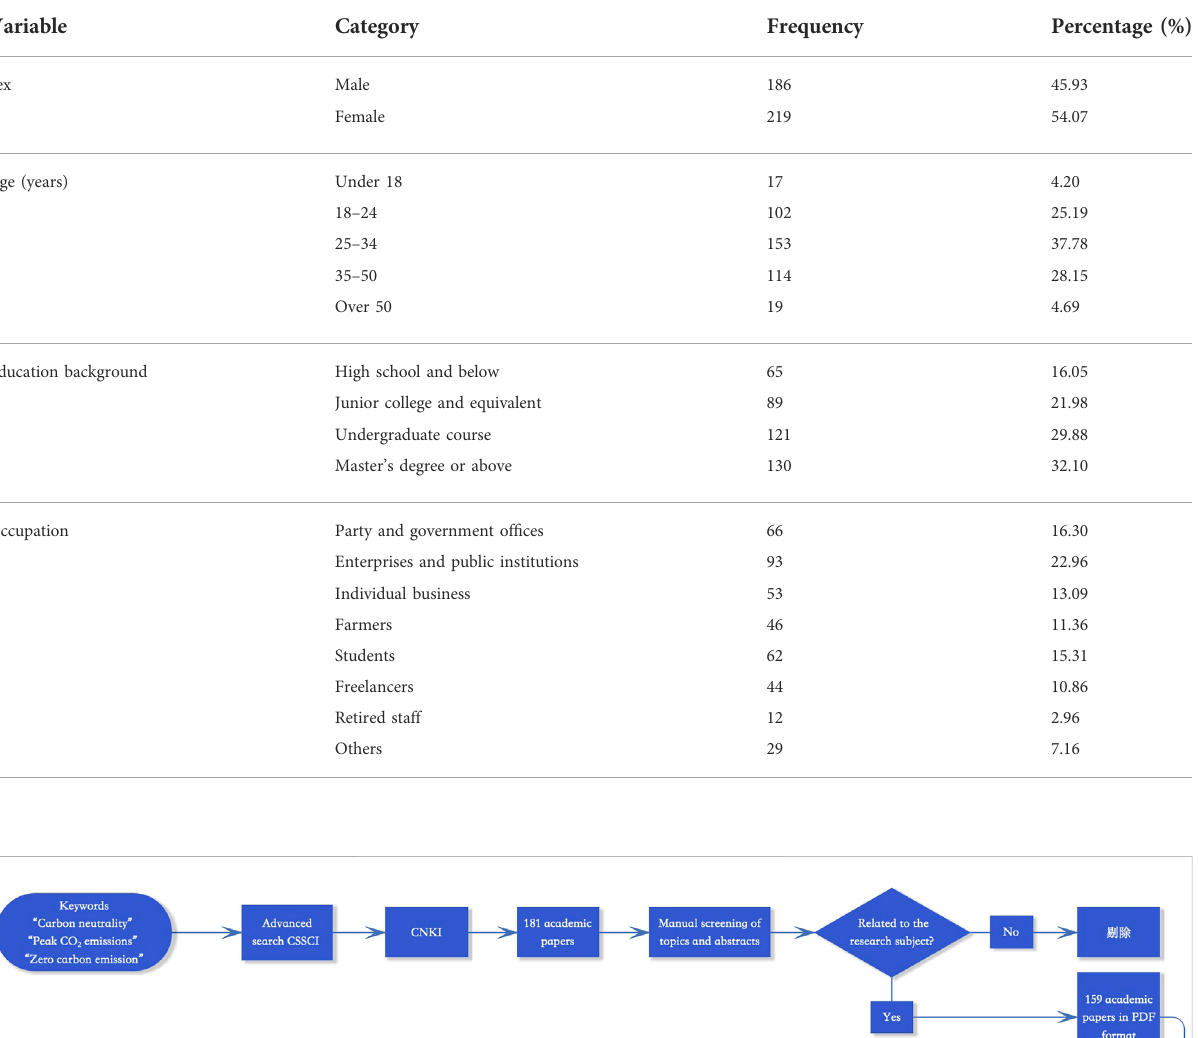
TABLE 1 Sample structure characteristics.